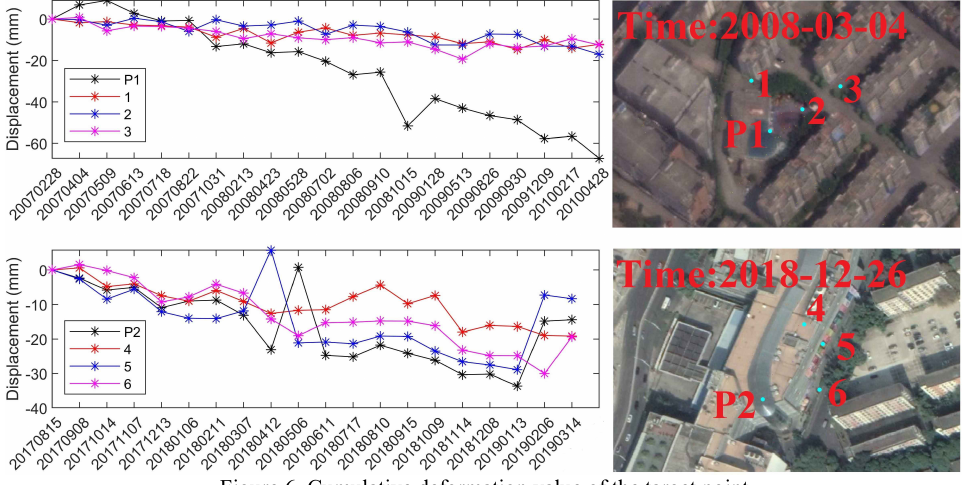
Figure 6. Cumulative deformation value of the target point